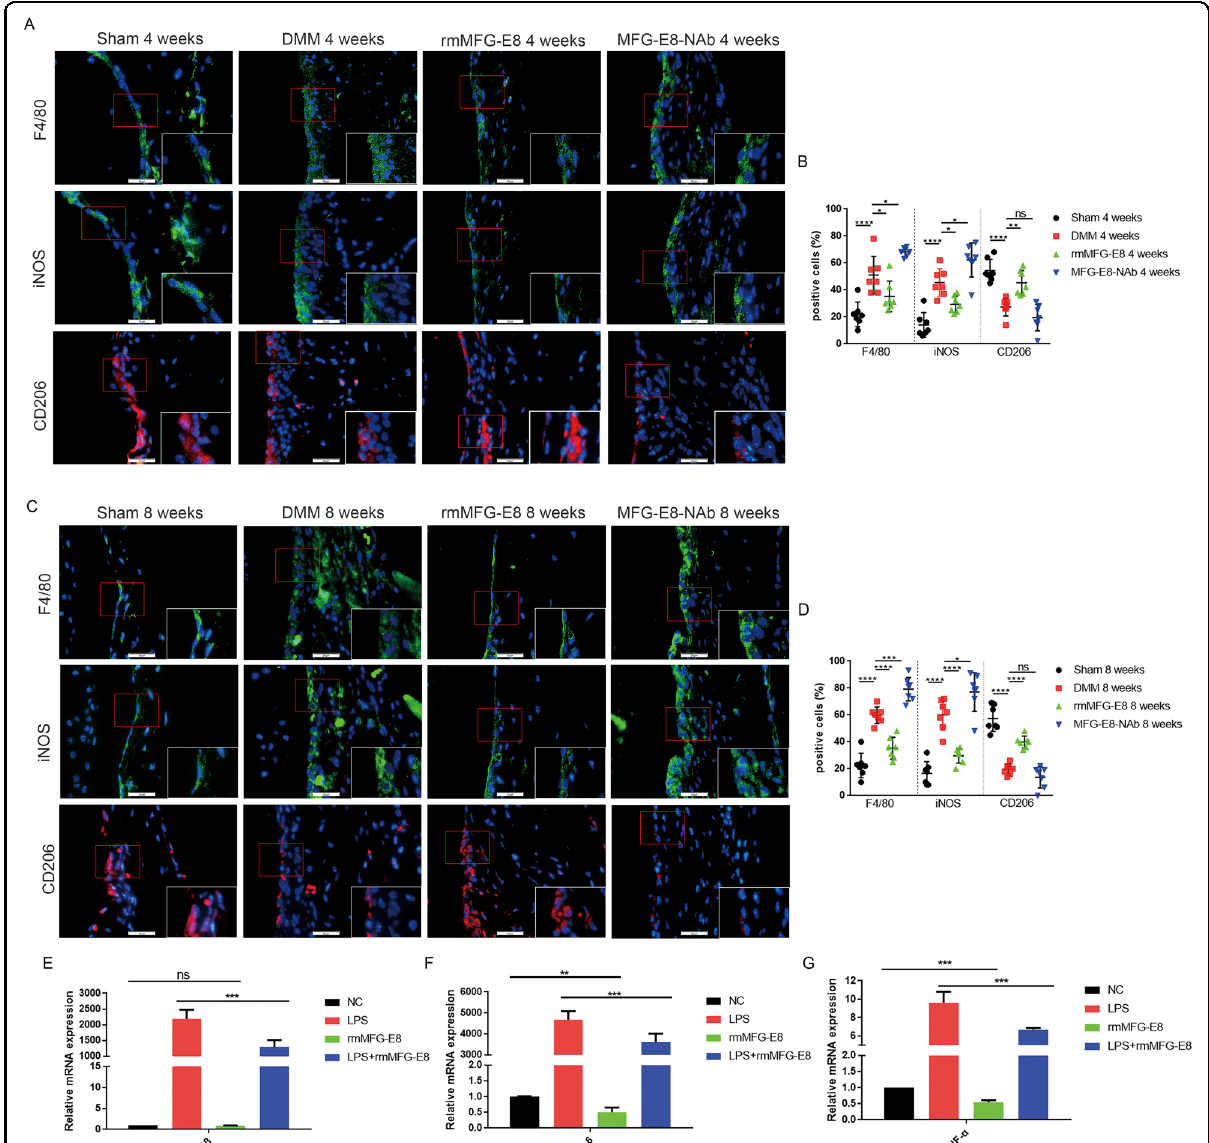
Fig. 4 MFG-E8 enhances M2 macrophage polarization and suppresses expression of in fl ammatory cytokines in OA synovium. Immuno fl uorescent staining and quanti fi cation of F4/80, iNOS and CD206 in synovial tissue of sham-operated mice and mice treated with vehicle, rmMFG-E8 and MFG-E8-NAb for 4 weeks ( A , B ) or 8 weeks ( C , D ). n = 7 per group; Scale bar: 25 µm. Relative mRNA expression level of IL-1 β ( E ), IL-6 ( F ) and TNF- α ( G ) in LPS- and rmMFG-E8-treated RAW264.7 cells, n = 3. * P < 0.05, ** P < 0.01, *** P < 0.001, **** P < 0.0001, ns not signi fi